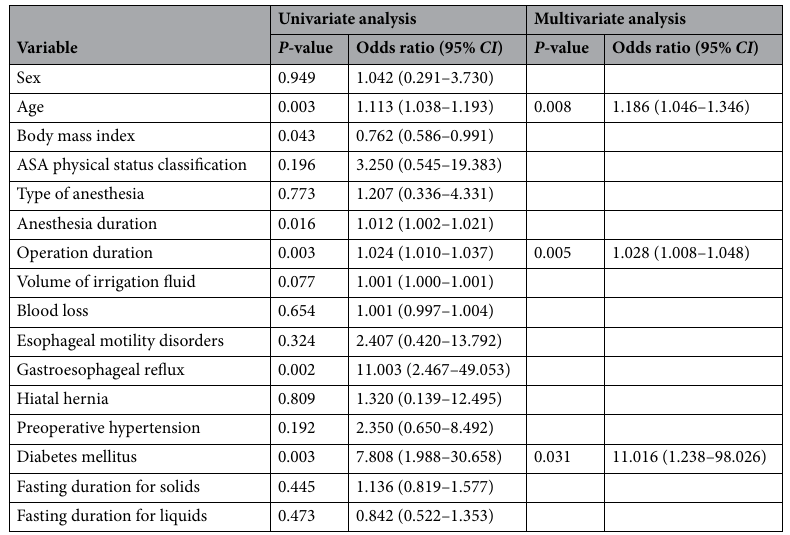
Table 4. Logistic regression analyses of the factors associated with postoperative risk stomach (> 1.5 mL kg −1